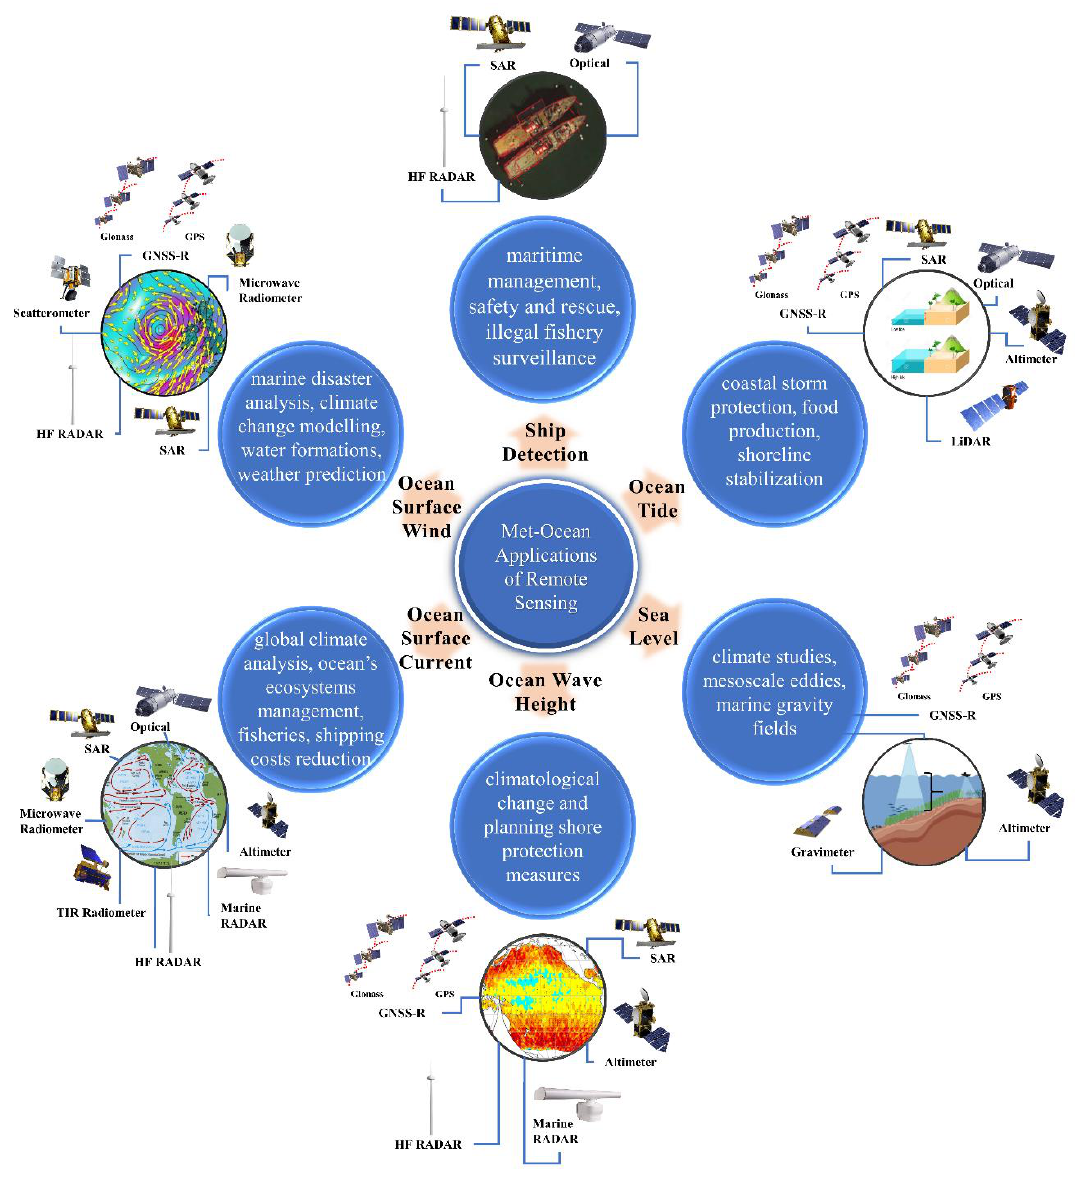
Figure 1. Overview of the met-ocean applications of RS which are discussed in this review paper.